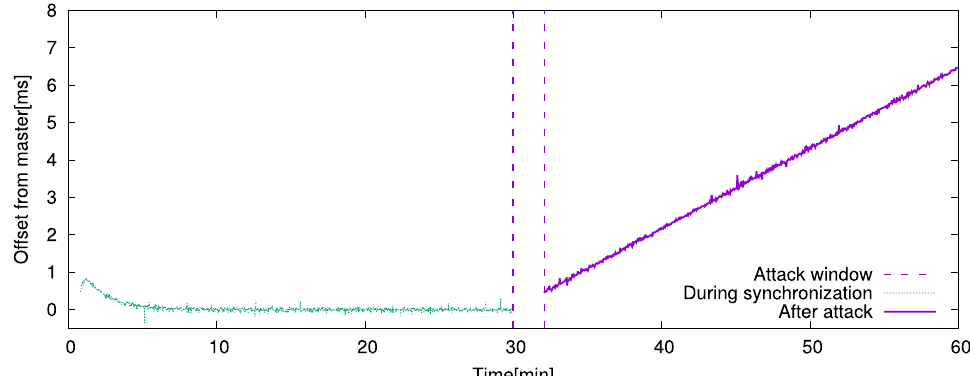
Fig. 6 Results of a clock de-synchronization attack in the virtualized testbed. In this attack we have exploited a DISABLE _ PORT TLV. The clock then proceeds to drift from the reference master; during the attack we keep the port disabled and then proceed to re-enable it after one minute